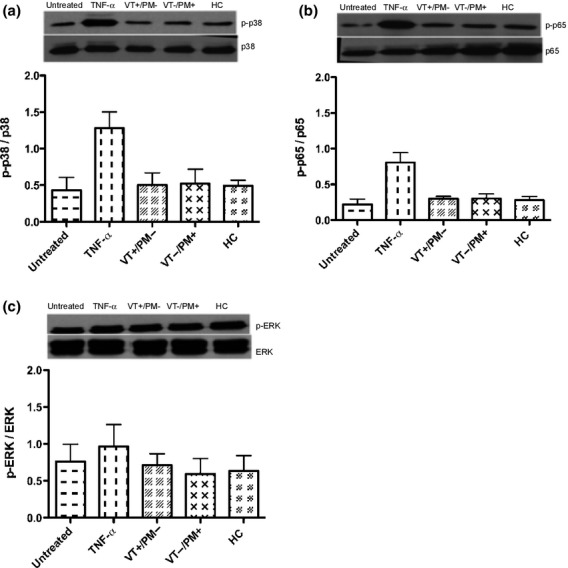
APS-IgG do not increase the phosphorylation of p38 MAPK, NFκB p65 or ERK. HTR-8 cells were treated with 100 μg/mL pooled IgG from VT+/PM− with 78.2GPLU and 44.4SU binding activity, VT−/PM+ with 83.4GPLU and 71.5SU binding activity and HCs with 0GPLU and SU binding as well as the positive controls TNF-α (10 ng/mL). Graphs show relative expression at 15 min of p38 MAPK (a), NFκB p65 (b) and ERK (c). The mean ± SEM of quantitative analysis from three independent experiments is shown. No statistically significant differences were found by one-way anova.